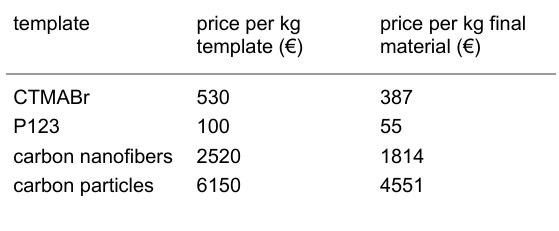
Table 2: Prices of templates used for the synthesis of nanoporous ma- terials